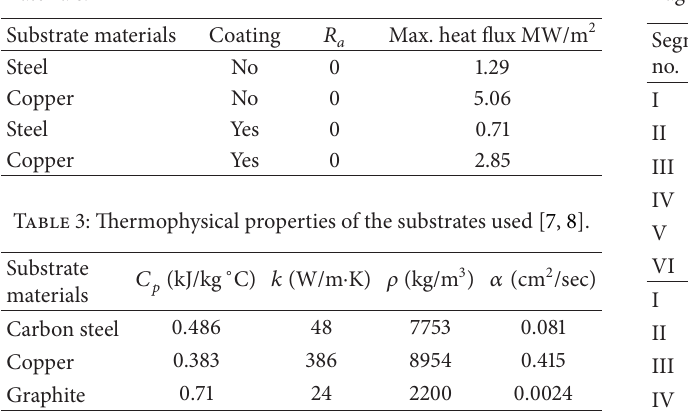
Table 2: Value of maximum heat flux for different substrate materials.